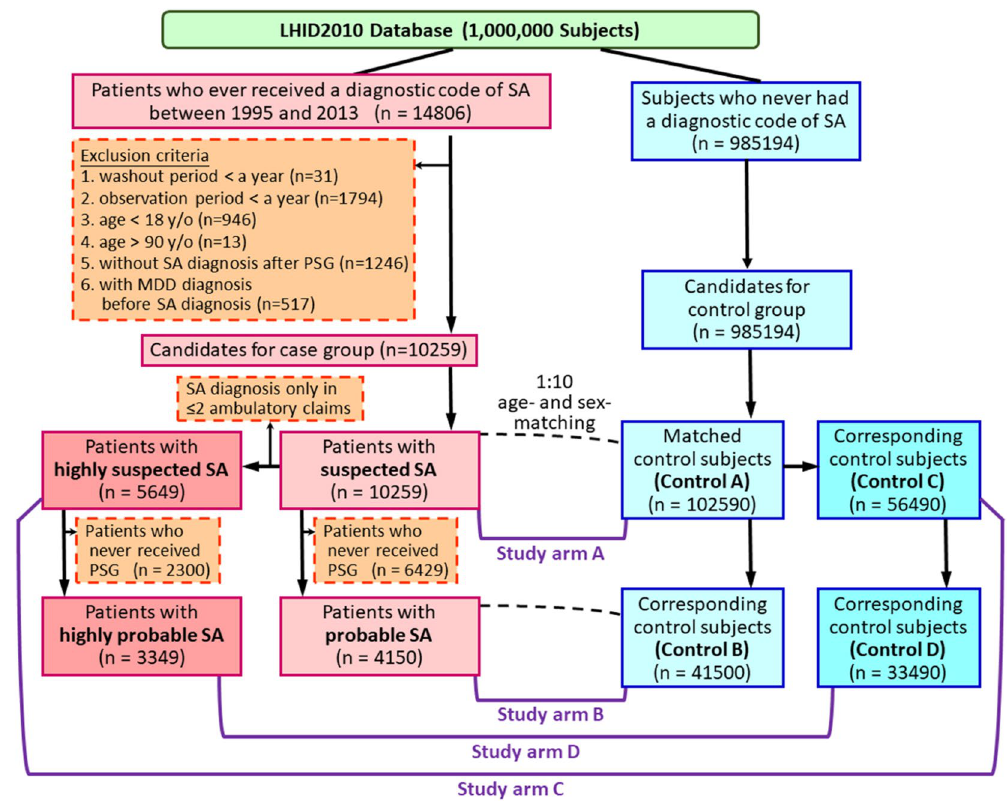
Figure 1. Algorithm for identifying the study population. SA sleep apnea, MDD major depressive disorder, PSG